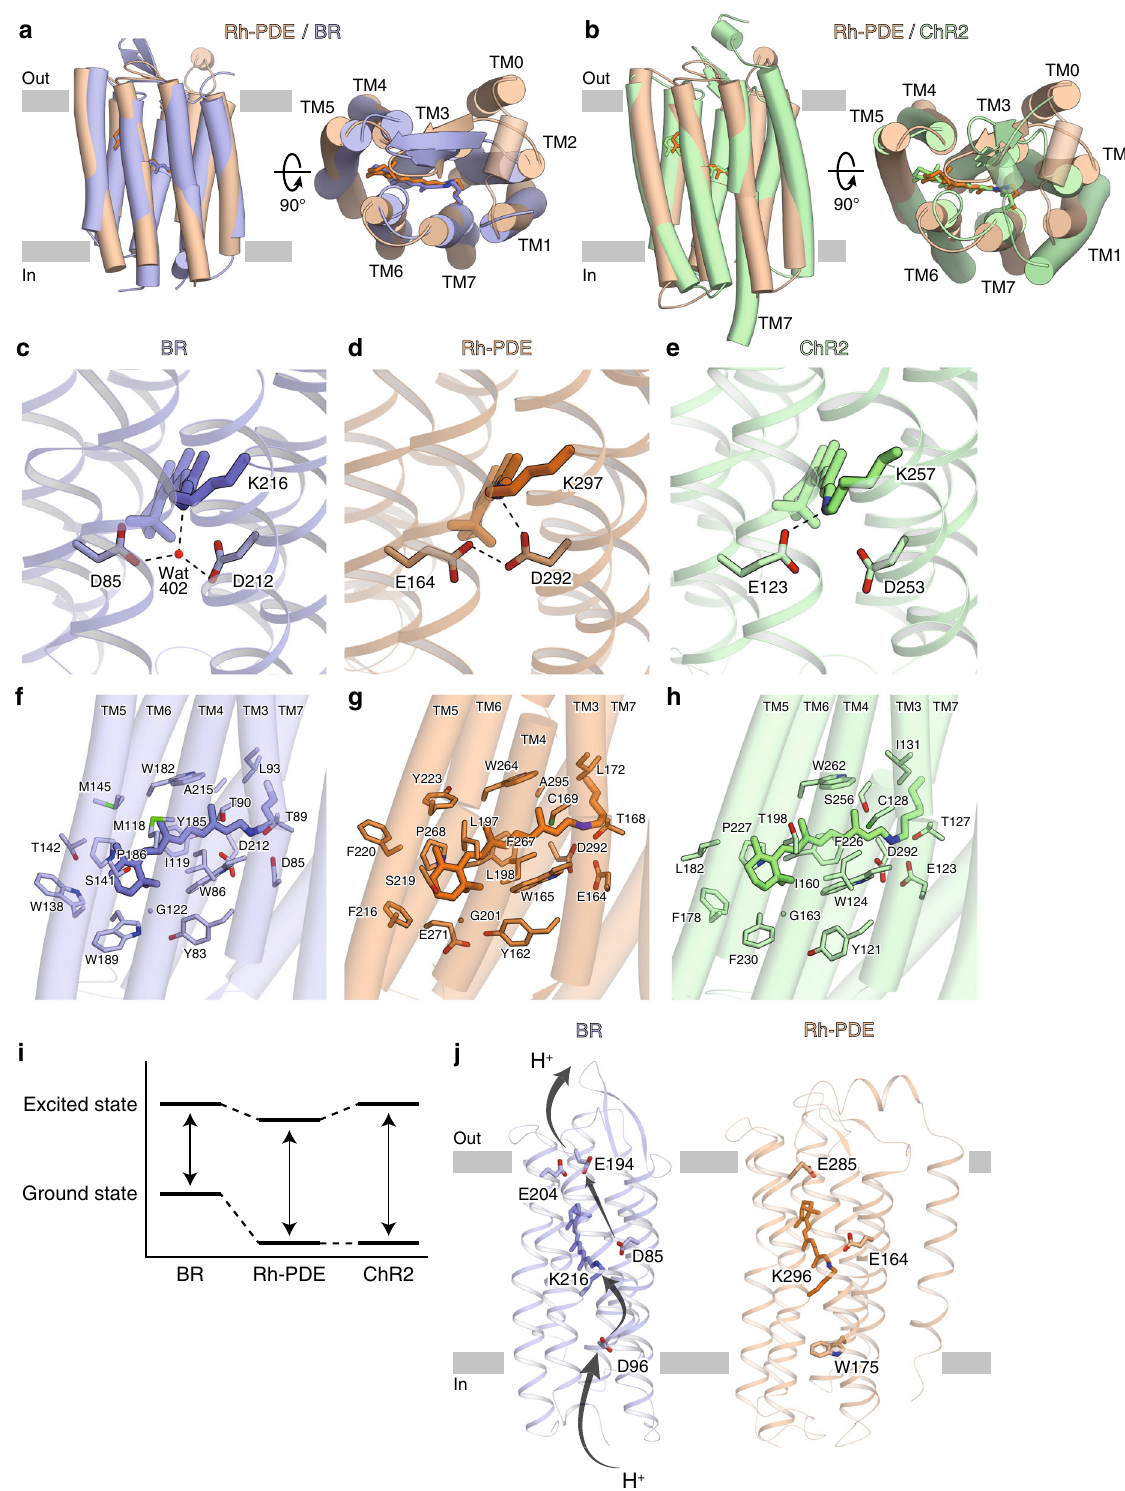
Fig. 2 Structural comparisons with BR and ChR. a , b Rh-PDE structure superimpositions on the BR structure ( a PDB ID: 1C3W) and the ChR2 structure ( b PDB ID: 6EID). Rh-PDE, BR, and ChR2 are colored orange, blue and green, respectively. c – e Residues around the RSBs of BR ( c ), Rh-PDE ( d ), and ChR2 ( e ). Dashed lines represent hydrogen bonds. f – h Structures of the retinal binding pockets of BR ( f ), Rh-PDE ( g ), and ChR2 ( h ). i Schematic diagram of the ground and excited states. j Residues contributing to proton transfer in BR (left) and corresponding residues in Rh-PDE